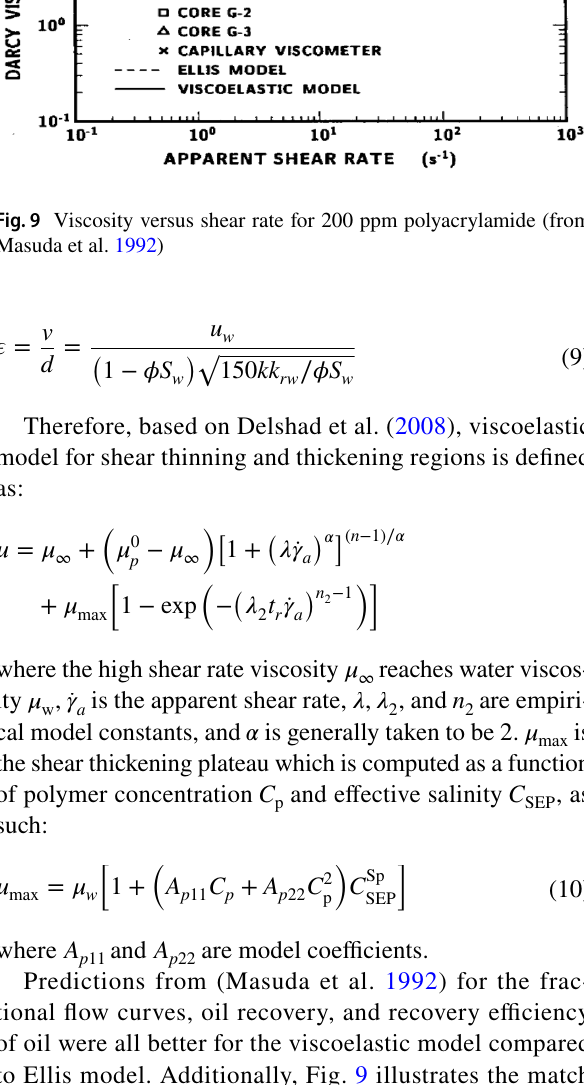
Table 2 Proposed equations for elongational viscosity